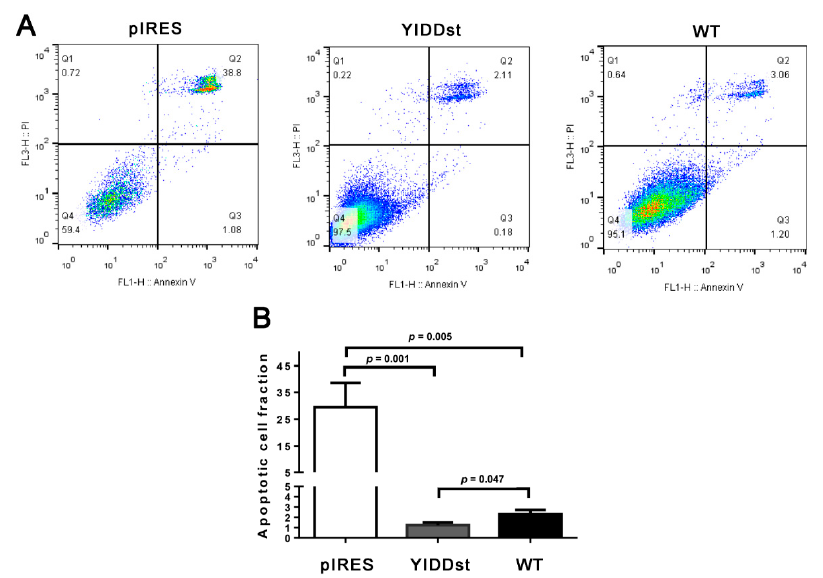
Figure 3. Apoptosis assay. ( A ) The rrepresentative Annexin V and Propidium Iodide (PI) flow cytometry shows significantly less camptothecin-induced apoptosis (Q2 + Q3) in the YIDDst and WT cells than the mock control-cells. ( B ) The bar chart shows the quantitative data of five individual assays; statistical analysis done using t